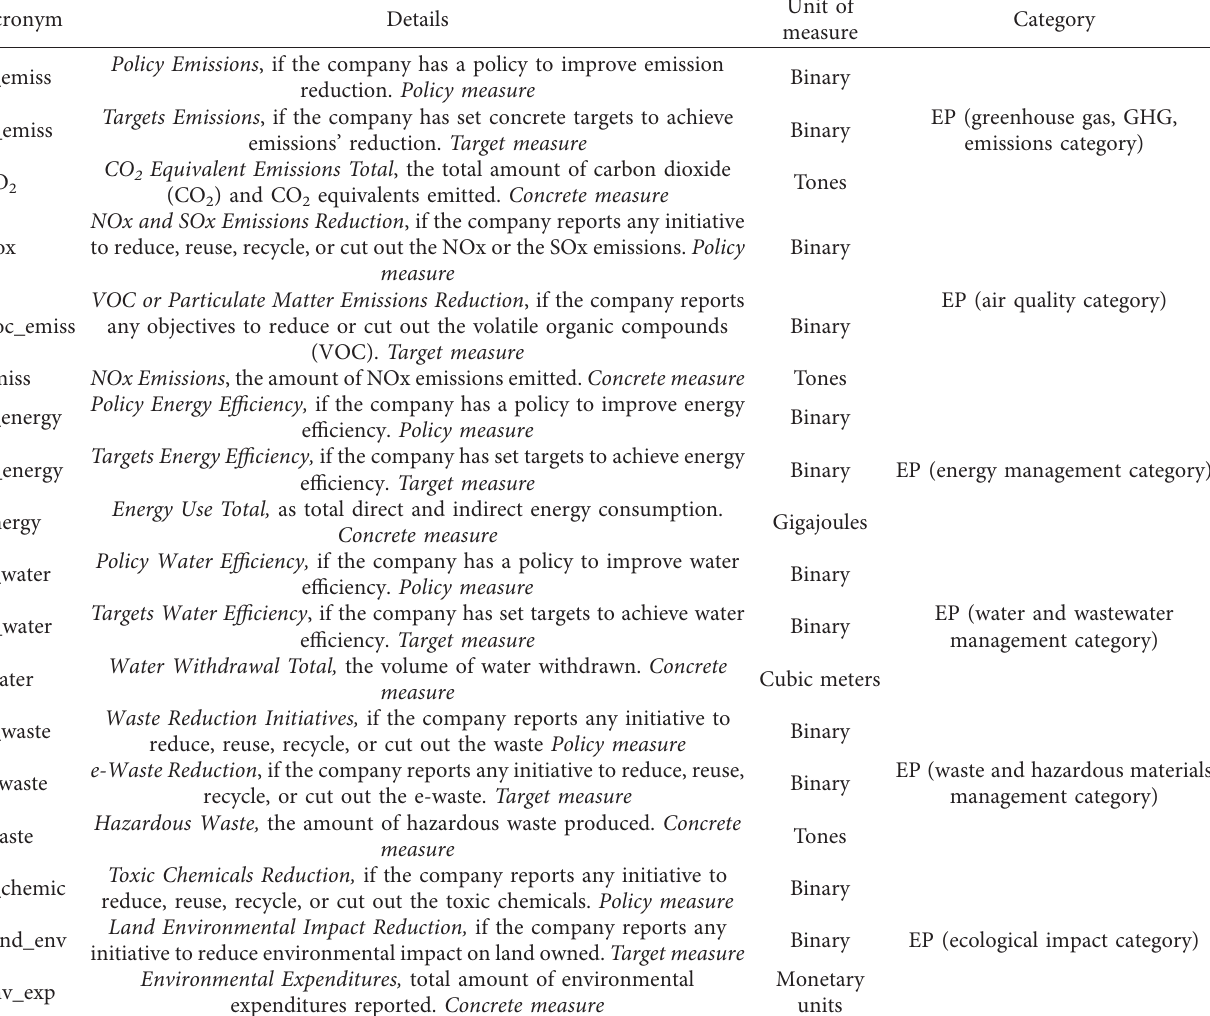
Table 1: Independent variables included within the econometric models.